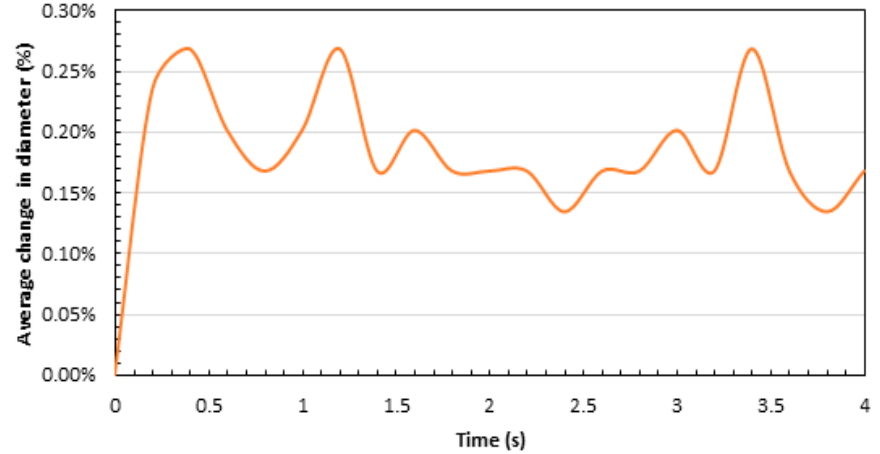
Figure 7. Average diameter change with time.